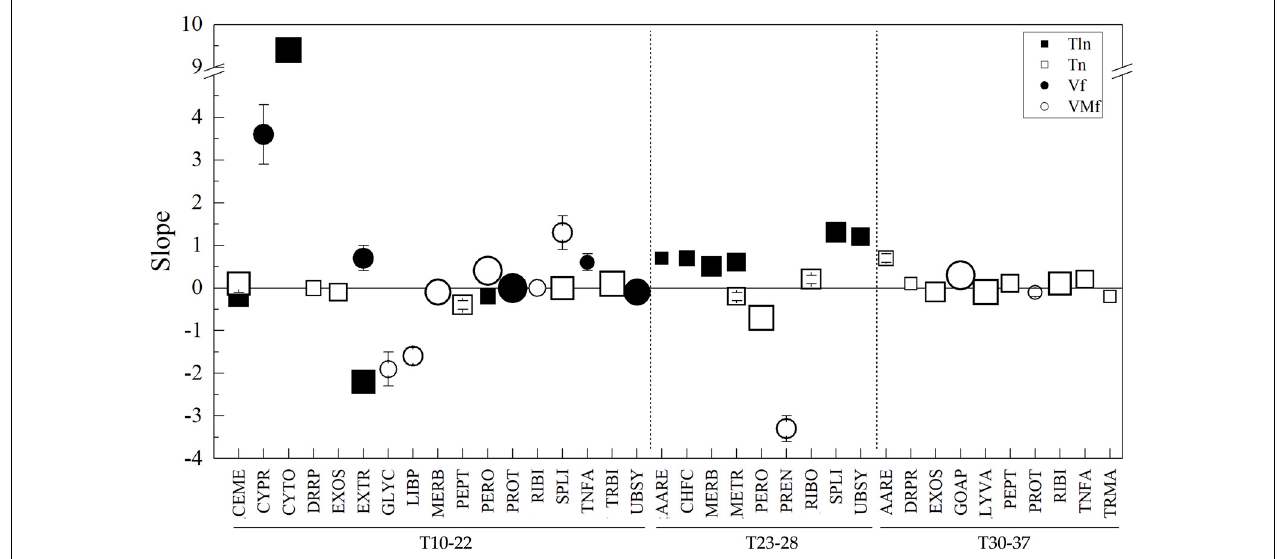
FIGURE 5 | Relationships between amino acid parameters and optimal temperature for the growth of yeasts from NCBI. The difference between yeasts in parameters by CDS groups (indicated in the X -axis) were plotted vs. their difference in optimal temperature for growth, and linear regression was applied. The slopes from regressions with R 2 ≥ 0.7 are shown. The size of the symbol represents R 2 from 0.7 to